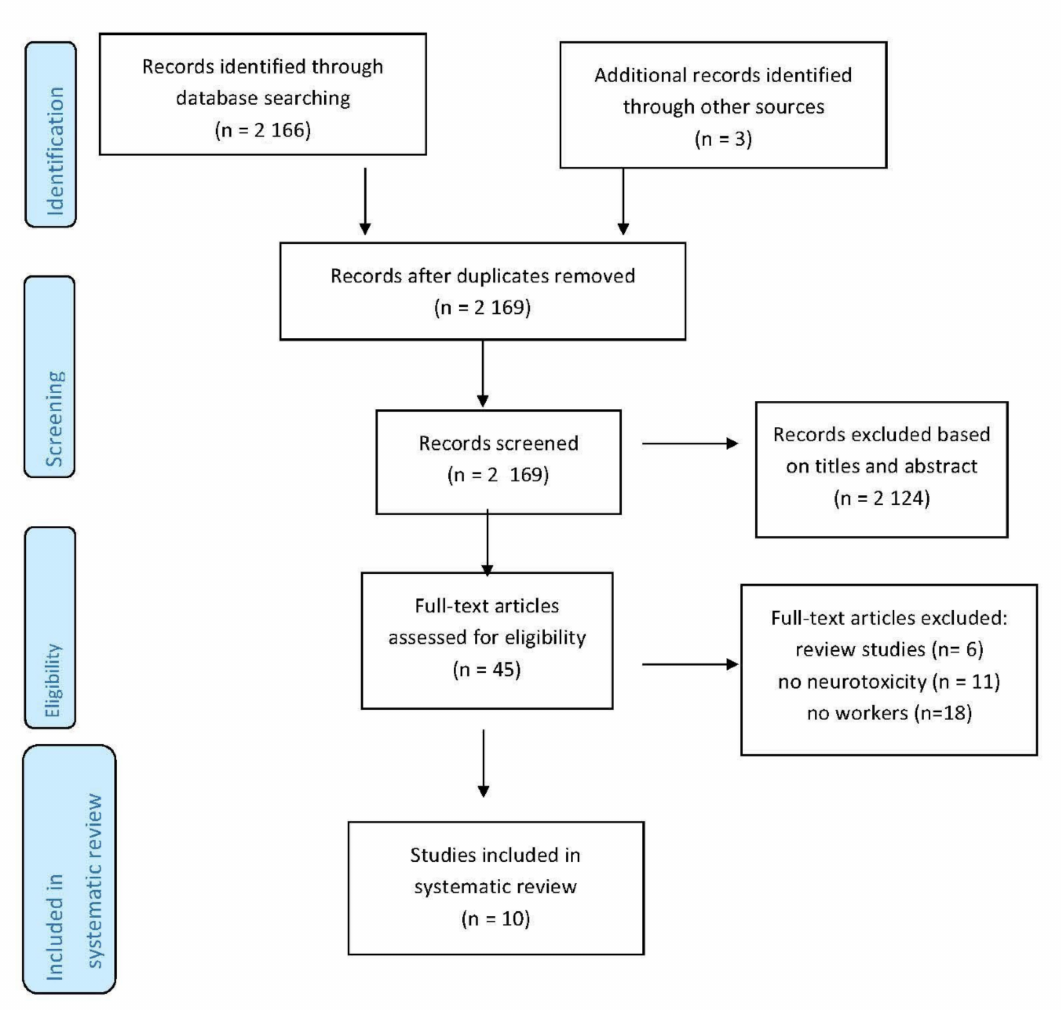
Figure 1. Article selection algorithm (PRISMA